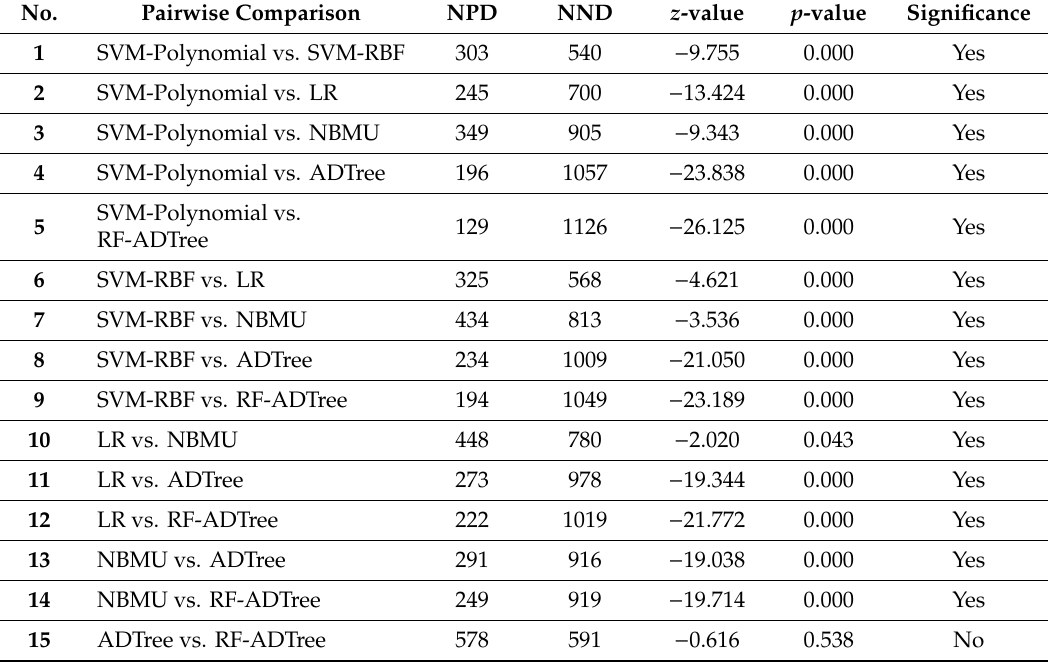
Table 6. Performance of the RF-ADTee model compared to other gully erosion models using Wilcoxon signed-rank test